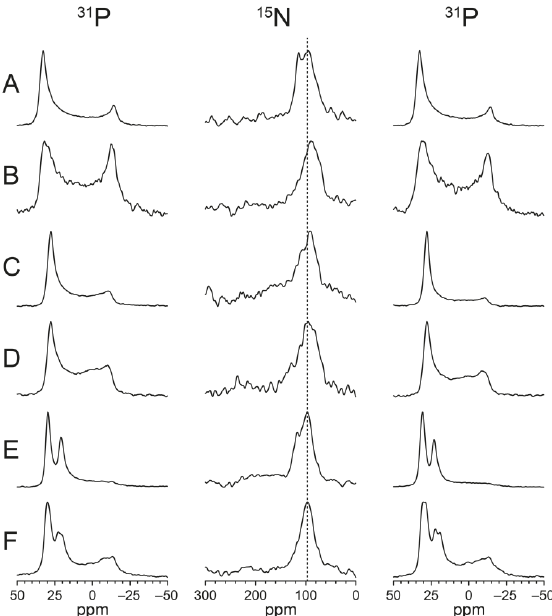
Figure 5. Solid-state NMR data on 15 N-labeled KL10 embedded in macroscopically aligned mem- branes with the sample normal aligned parallel to the static magnetic field direction. The middle column shows the 15 N-NMR spectra. 31 P-NMR spectra before (on the left side) and after 15 N-NMR experiments (on the right side) are also given. The lipid systems are ( A ) DMPC, P/L = 1/50; ( B ) DMPC, P/L = 1/20; ( C ) POPC/POPG (1/1), P/L = 1/100; ( D ) POPC/POPG (1/1), P/L = 1/50; ( E ) DMPC/lyso-MPC (2/1), P/L = 1/50; ( F ) DMPC/lyso-MPC (2/1), P/L = 1/20. (P/L ratios are for KL14, and the same peptide-to-lipid mass ratios were used for